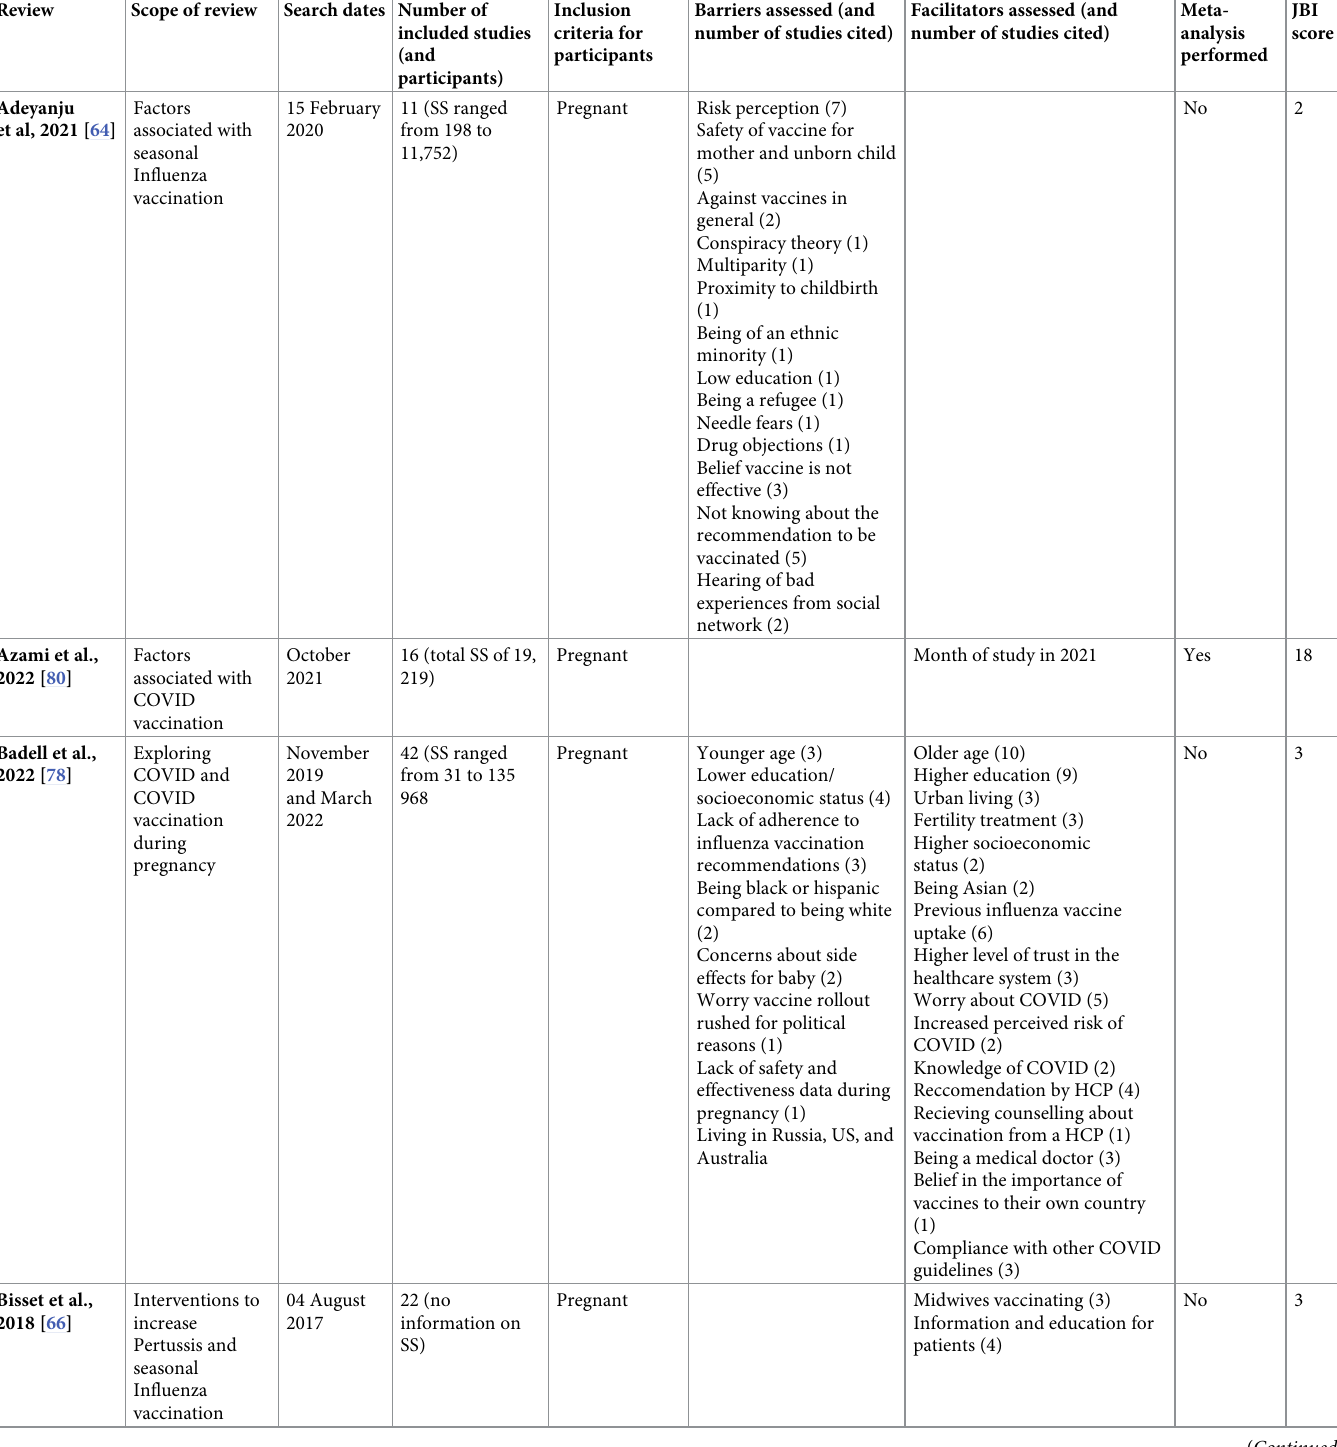
Table 2. Characteristics of included reviews. Note, the conclusion of whether a meta-analysis was performed was based on whether it was performed for the outcome of interest (i.e not for safety of vaccination). SS = sample